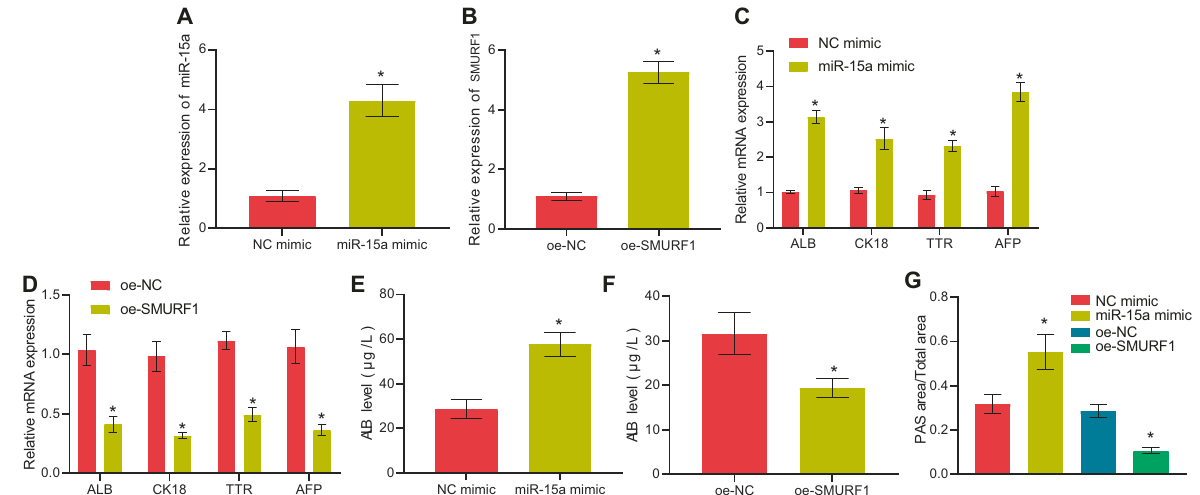
Fig. 4 miR-15a and SMURF1 mediate HLC differentiation of BMSCs. A RT-qPCR validation of miR-15a mimic transfection ef fi ciency in HGF- treated BMSCs. B RT-qPCR validation of oe-SMURF1 overexpression ef fi ciency in HGF-treated BMSCs. C Changes in the levels of hepatocyte- related genes after overexpression of miR-15a for 14 days determined by RT-qPCR. D Changes in the levels of hepatocyte-related genes after overexpression of SMURF1 for 14 days measured by RT-qPCR, E RT-qPCR to assess the ALB content in the culture supernatant of BMSCs after overexpressing miR-15a for 14 days. F RT-qPCR to evaluate the secretion of ALB of BMSCs after overexpressing SMURF1 for 14 days; G Glycogen content in BMSCs after overexpressing miR-15a or SMURF1 for 14 days detected by PAS staining. * p < 0.05 vs . BMSCs transfected with oe-NC or NC mimic. The cell experiments were repeated three In conclusion, lncRNA SNHG1 restricted HLC differentiation of Meanwhile, miR-15a mimic enhanced HLC differentiation of mouse BMSCs through sponging miR-15a and thus upregulating BMSCs, whereas simultaneous overexpression of SMURF1 SMURF1 expression. abrogated this effect (Fig. 6D – F).